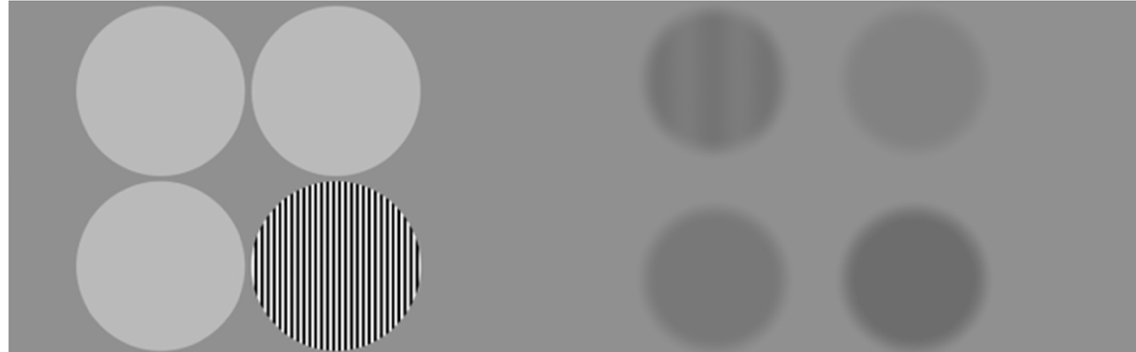
Figure 2. Example screen during the VA test (left) and the CS test (right). DIVE uses a psychophysical adaptive method to present the stimuli. The range of stimuli in grating VA starts at 0.25 cycles per degree (cpd) and reaches up to 18 cpd. The CS test was performed with stimuli of 0.5 cpd. The range of contrasts displayed starts at 99% of contrast (0.0 uLog) up to 0.3% (3 uLog). After the tests, apart from the visual outcomes, DIVE scored the quality and reliability of each exam based on several internal parameters. The test had to achieve at least 3 points on a scale of 1 to 5 to be included. 2.4. Statistical Analyses Statistical analyses were carried out with the statistical software SPSS 21.0 (SPSS Inc., Chicago, IL, USA). Student’s t-test, chi-square test or ANOVA were used to compare the outcomes between the study groups and age ranges. A p value lower than 0.05 was considered statistically significant. Normative curves were created using the GAMLSS (Generalized Additive Models for Location, Scale and Shape) package in R [4]. The Akaike information criteria [5] and Q-test were used to evaluate goodness of fit. The models for all the variables included parameters that account for skewness and kurtosis in the distribution of the values. Additionally, age-adjusted VA and CS tolerance limits were reported, as the range in which 90 percent of a normally distributed population is found, with 95% probability. Regression models were performed including age at the study, gestational age at birth, sex, ethnicity, previous retinopathy of prematurity and refractive error as independent variables and VA or CS as dependent variables. The strength of the effect of each independent variable on visual outcomes was compared by the standardized beta coefficient (b std ). 3. Results 3.1. Testability Out of 2208 tested children, 97% (2134 children) were able to complete the VA test, and 89.13% (1968 children) met the quality criteria to be included. There were significant differences in excluded children between study groups, with a higher percentage of excluded children in the Pre group than in the Norm group (17.8% vs. 8.45%, p < 0.001). Regarding CS, 96% (2118 children) completed the test, while 87.41% (1930 children) obtained reliable data and were included. Exclusion rates were also higher in the Pre group (19.87% vs. 9.82%, p < 0.001). VA test was performed binocularly by 307 children (15.5%) with a mean age of 2.15 y (standard deviation (s. d) 1.55). CS test was performed binocularly by 229 children (11.8%) with a mean age of 2.27 y (s. d 1.66). Mean times to complete the DIVE tests are 50 s for the initial calibration, 31.4 s for the VA test and 35.9 s for the CS test.